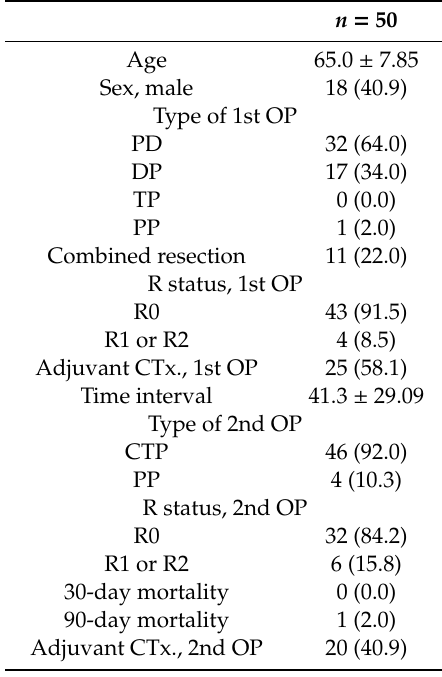
Table 2. Characteristics of the patients undergoing repeated pancreatectomy for recurrent pancreatic ductal adenocarcinoma included in the pooled analysis.